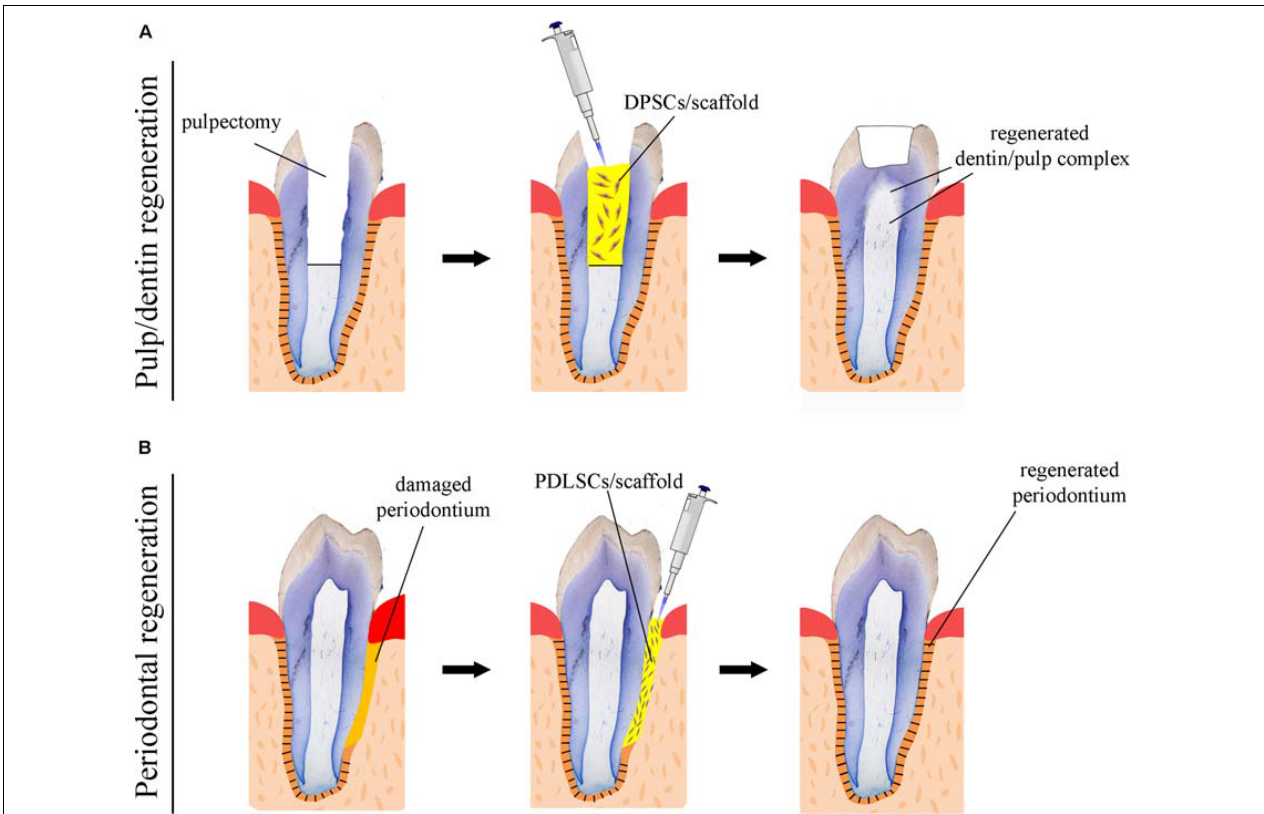
FIGURE 2 | Schematic representation of stem cell-based regenerative approaches in dentistry. (A) Use of scaffolds (yellow color) seeded with dental pulp stem cells (DPSCs) for the repair of the dentin-pulp complex. (B) Use of scaffolds (yellow color) seeded with periodontal ligament stem cells (PDLSCs) for the regeneration of the damaged